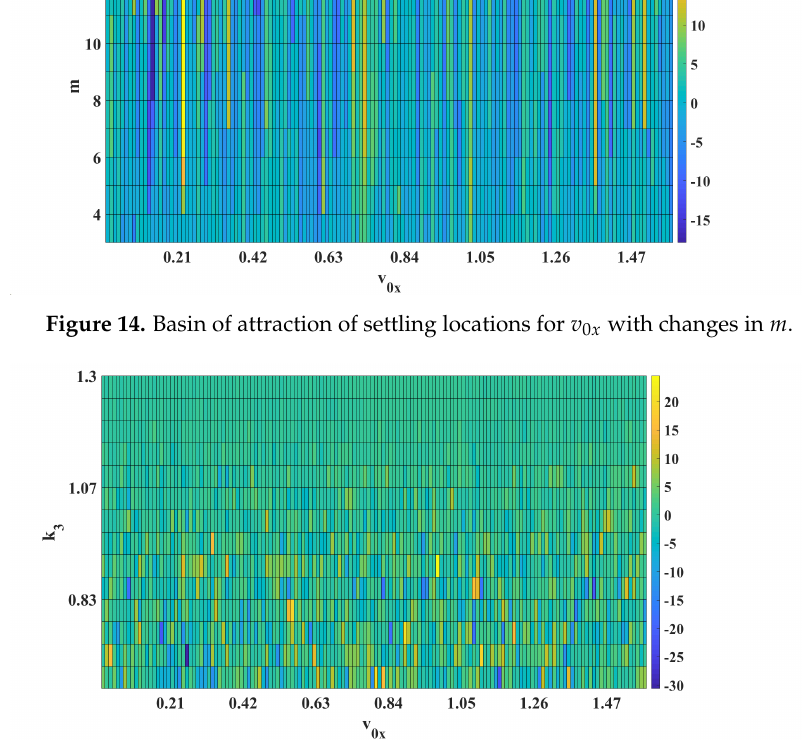
Figure 15. Basin of attraction of settling locations for v 0 x with changes in k 3